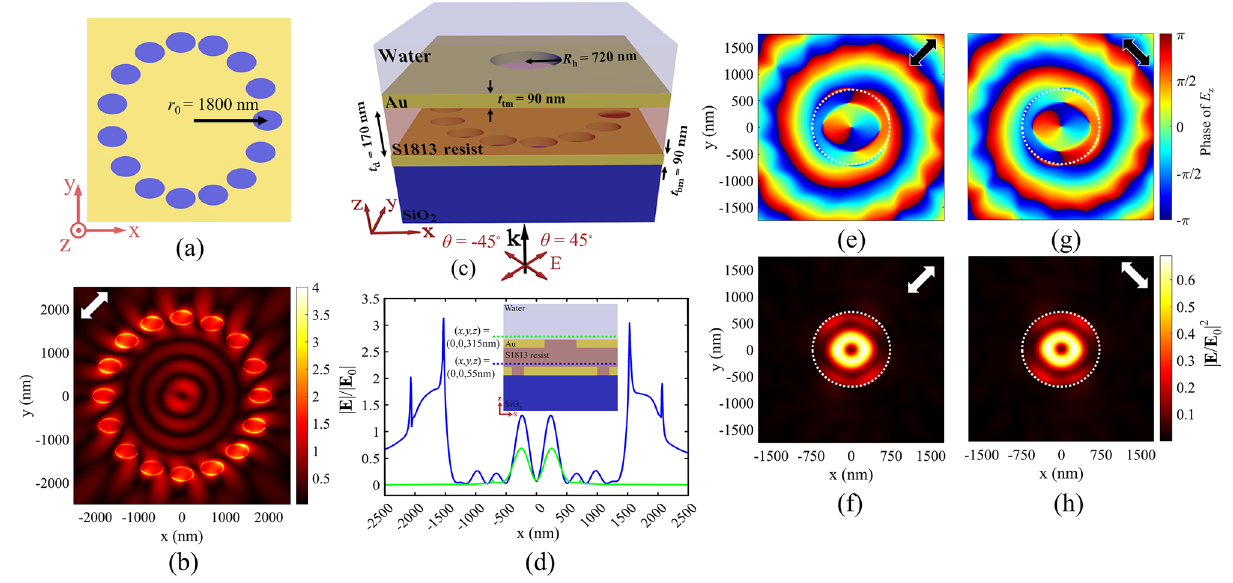
Figure 2. ( a ) Two-dimensional schematic diagram of a circular array of elliptical holes embedded in a gold layer, and ( b ) the relating normalized electric field distribution for θ = 45°. ( c ) Three-dimensional scheme of the proposed MIM structure (design I). ( d ) Normalized electric field along x -axis at y = 0, for z = 55 nm (green curve) and z = 315 nm (blue curve). ( e , f ) Phase distribution of E z and the normalized field intensity distribution for θ = 45°. ( g , h ) Phase distribution of E z and the normalized field intensity distribution for θ = − 45°. White dashed circles illustrate the boundary of the central circular hole etched in the top metal layer. White and black arrows indicate orientations of incident linear